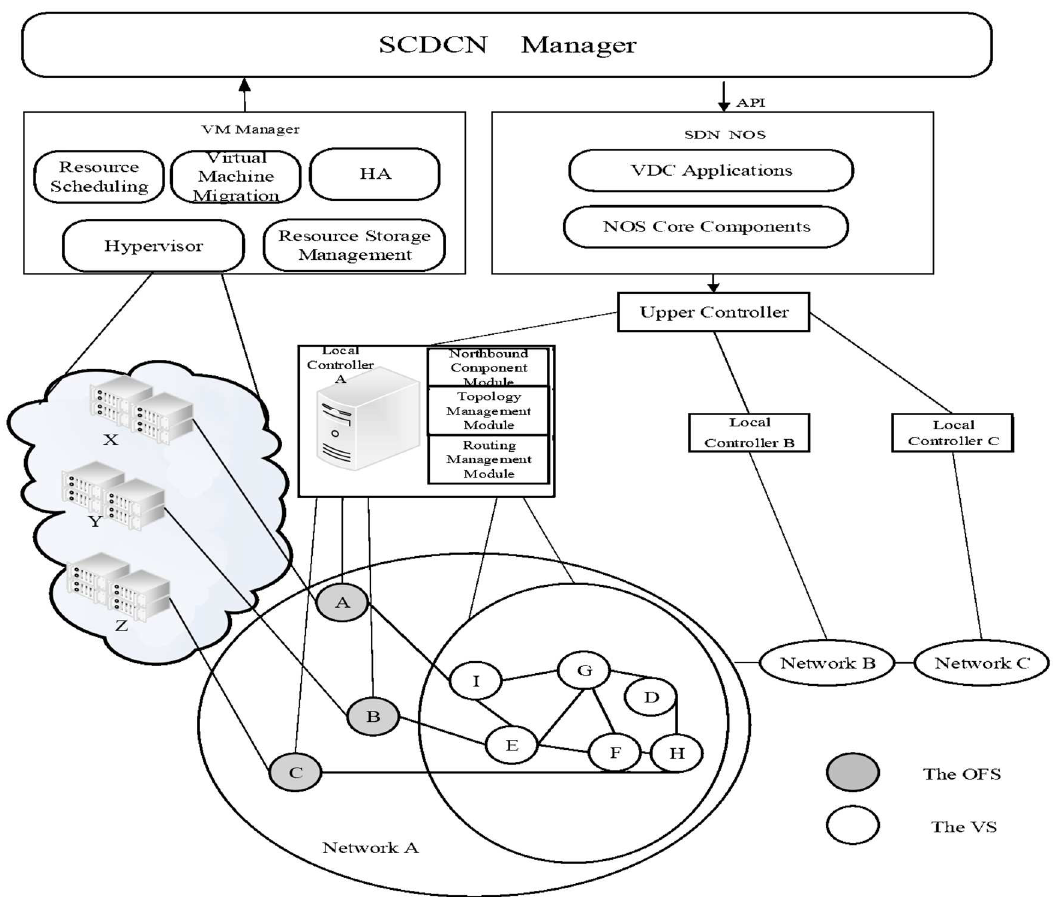
Fig 4. The architecture of the SCDCNmodel. The model makes network resourcesbe unified with computing and storage resourcesand provides openinterfaces for upper application by applyingtechniquesof VA and SDN techniques.